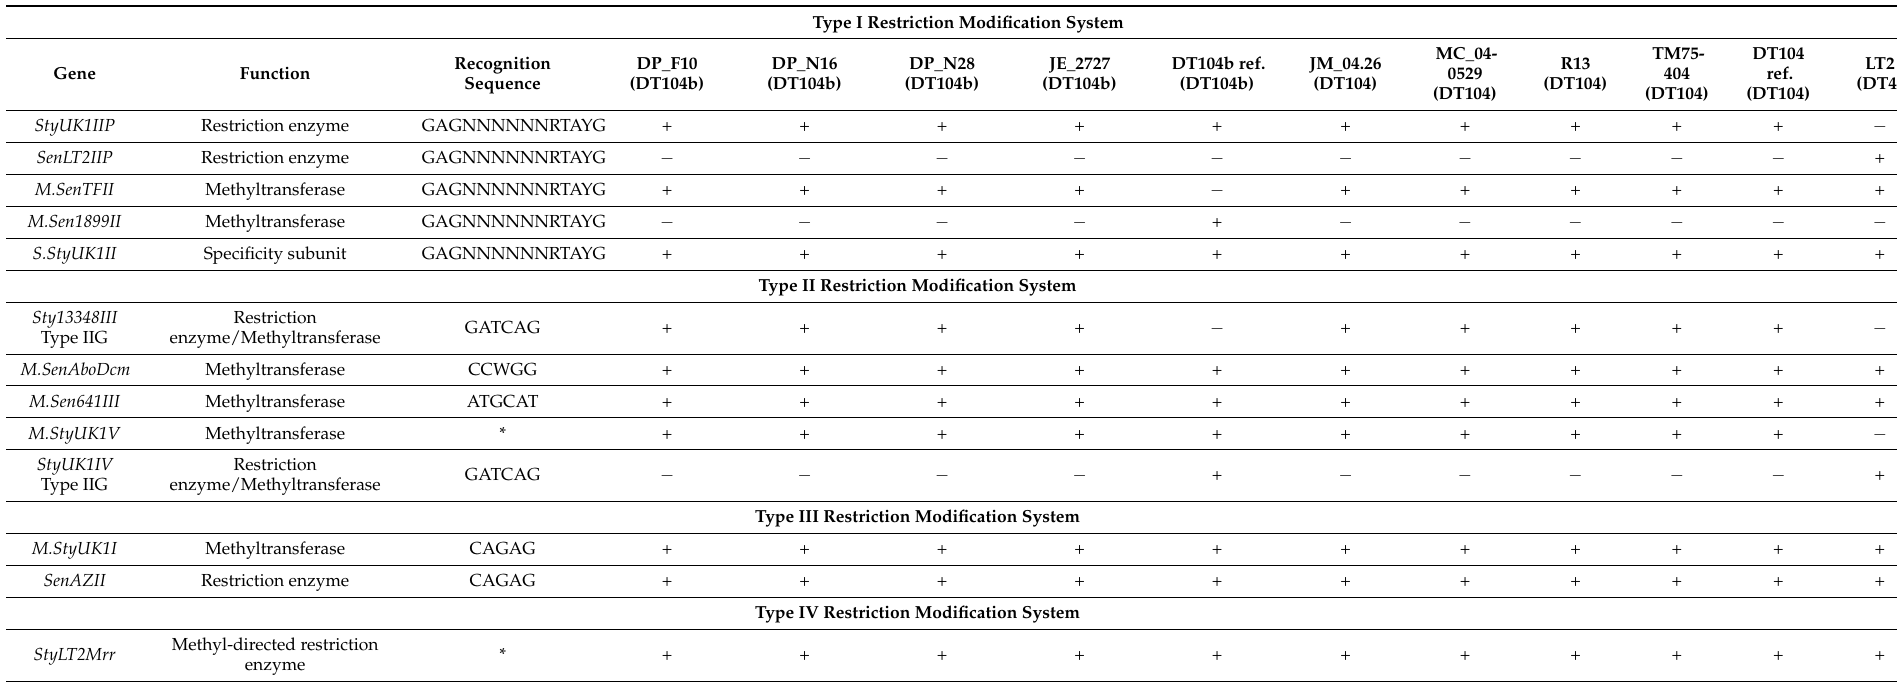
Table 5. Four distinct types of restriction–modification systems in the studied S. Typhimurium genomes. +, identified; − unidentified; *,